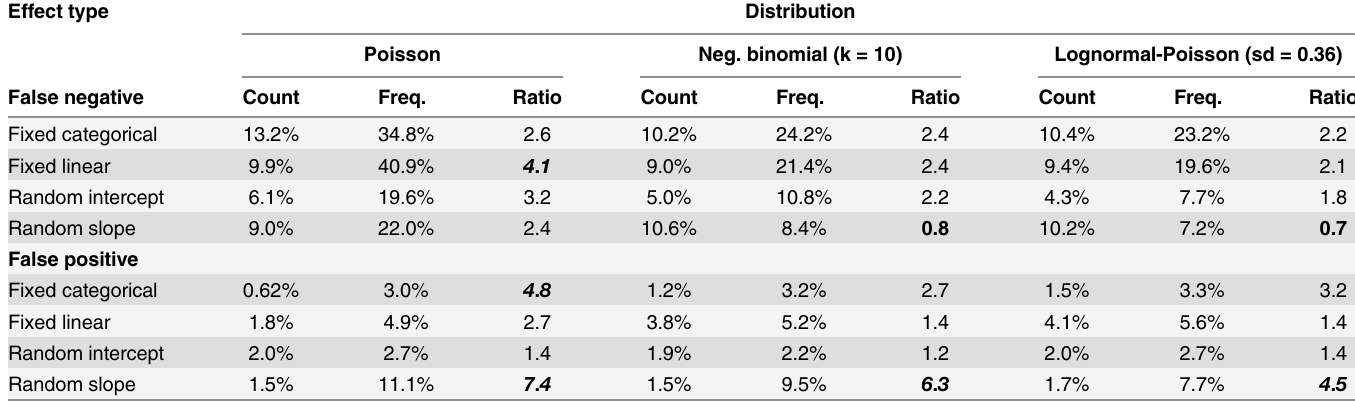
Table 1. False negative rate (type II error, upper panel) and false positive rate (type I error, lower panel) for the analyses of 10000 simulated data- sets in each case. The datasets were generated by use of three different distributions (Poisson, Negative binomial and lognormal Poisson). The best model (Poisson, negative binomial and zero-inflated negative binomial for count data) with and without effect was identified and compared to each other using BML. Datasets with an effect were simulated so as to yield approximately 10% false negative for the count data analysis. Each cell contains the percentage of false negatives/positives for the data type (count of frequency) followed by the ratio between them (frequency score divided by count data score). Note that a ratio > 1 is favoring the count data approach while ratio < 1 is favoring the frequency approach. These are indicated in bold. Ratios larger than 4 in favor of count data is indicated with bold italic